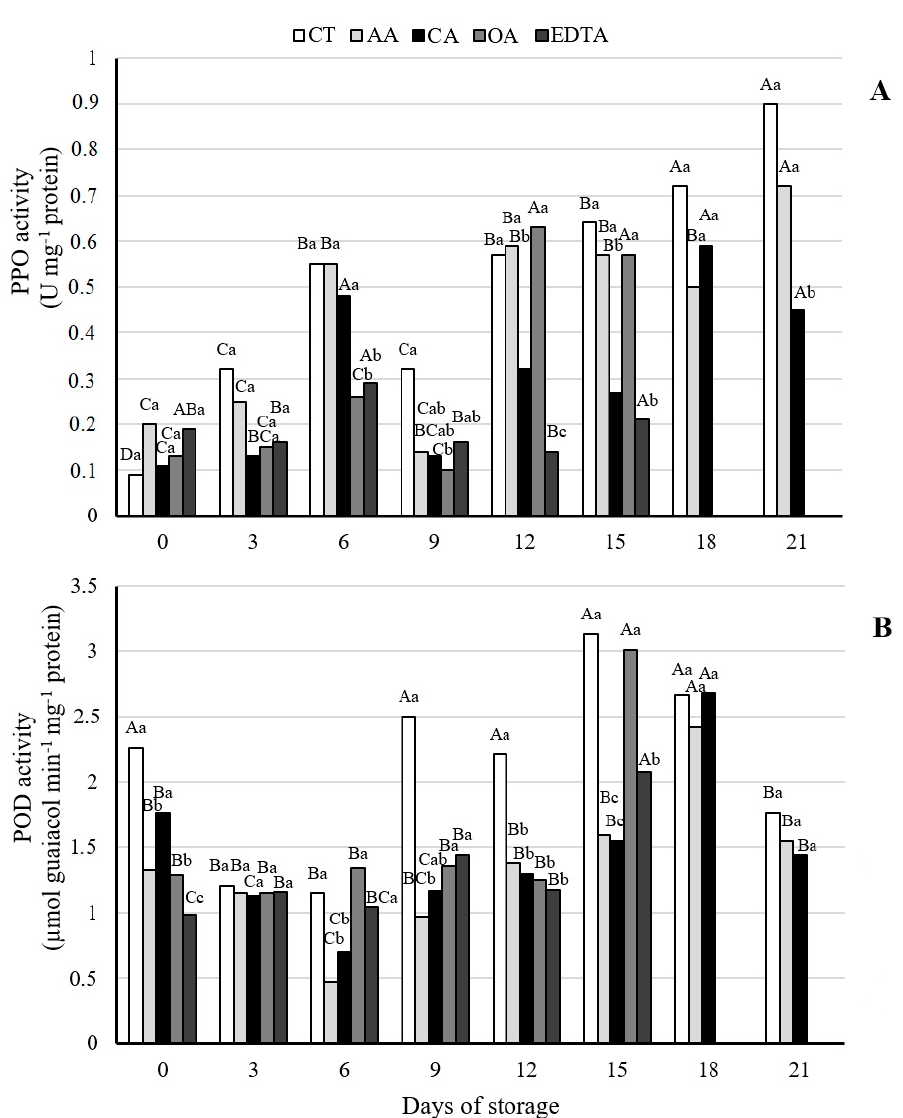
Figure 2. Polyphenoloxidase activity (U mg − 1 protein) ( A ) and peroxidase activity ( μ mol guaiacol min − 1 mg − 1 protein) ( B ) in minimally-processed escarole treated with antioxidants and stored at 0 °C and 90–95% relative humidity for 21 days. The columns represent the average of three replicates. Means followed by different uppercase letters within each day of storage and lowercase letters between treatments differ from each other by Tukey’s test ( P ≤ 0.01). CT: control; AA: 1% ascorbic acid; CA: 1% citric acid; OA: 1% oxalic acid; and 2% EDTA: ethylenediaminetetraacetic acid.